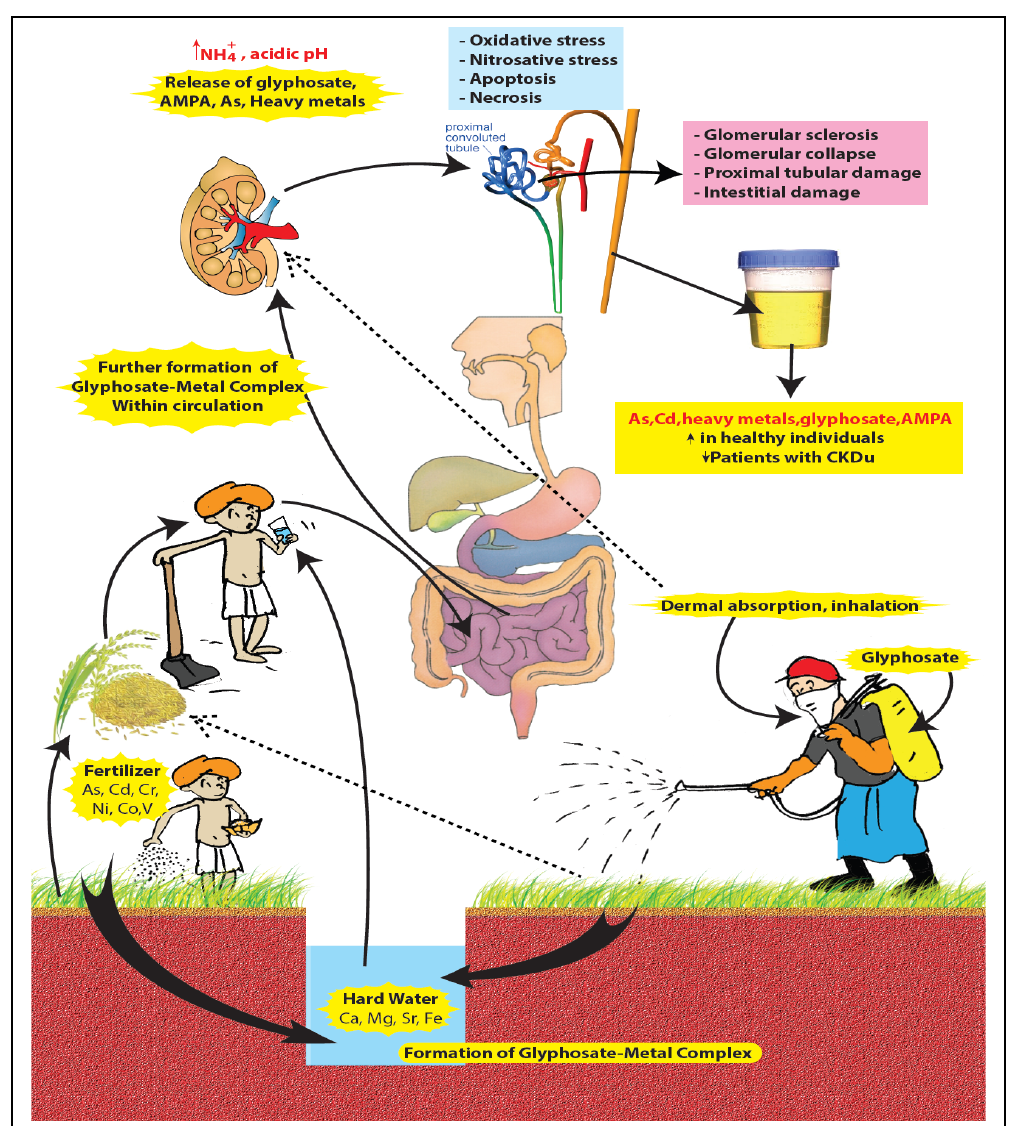
Figure 6. GMA lattice hypothesis in